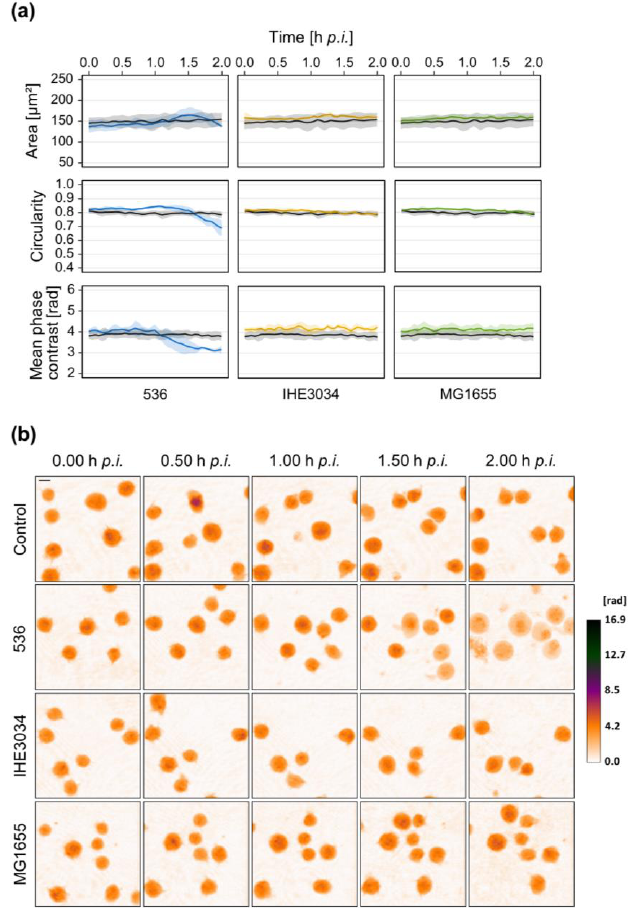
Figure 5. Early cellular changes of Jurkat cells infected with living E. coli . Jurkat cells were infected with different E. coli strains (MOI 10) and DHM was started directly after the addition of the bacteria. Mock-infected cells served as control. ( a ) DHM quantitative phase contrast images were analyzed for the average single-cell area (µm 2 ), average circularity (AU), and mean phase contrast (rad) per cell. Results are shown as mean (lines) ± SD (shading) of at least three independent experiments. Controls are depicted in black while different colors represent the individual strains. For better visualization, curves were smoothed using moving averages with a window size of 2 measuring points. ( b ) Representative color-coded phase contrast images of Jurkat cells at indicated time points after the addition of bacteria. The scale bar corresponds to 10 μm. The calibration bar indicates phase contrast values in radian.